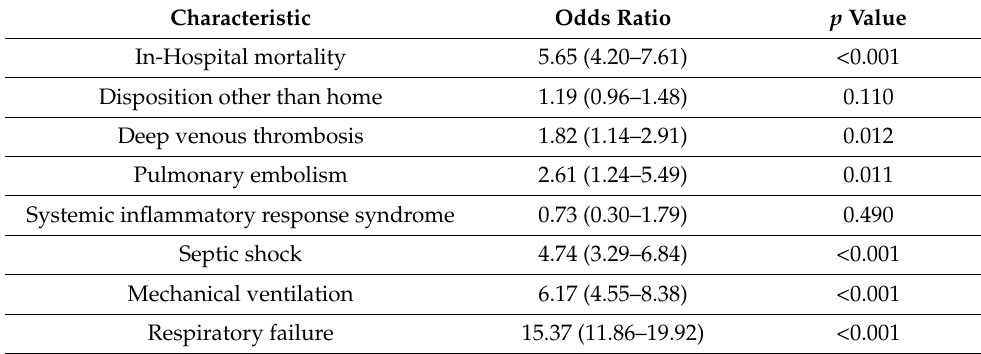
Table 3. Conditional logistic regression of hospital outcomes between COVID-19 hospitalizations with AIS and AIS hospitalizations without